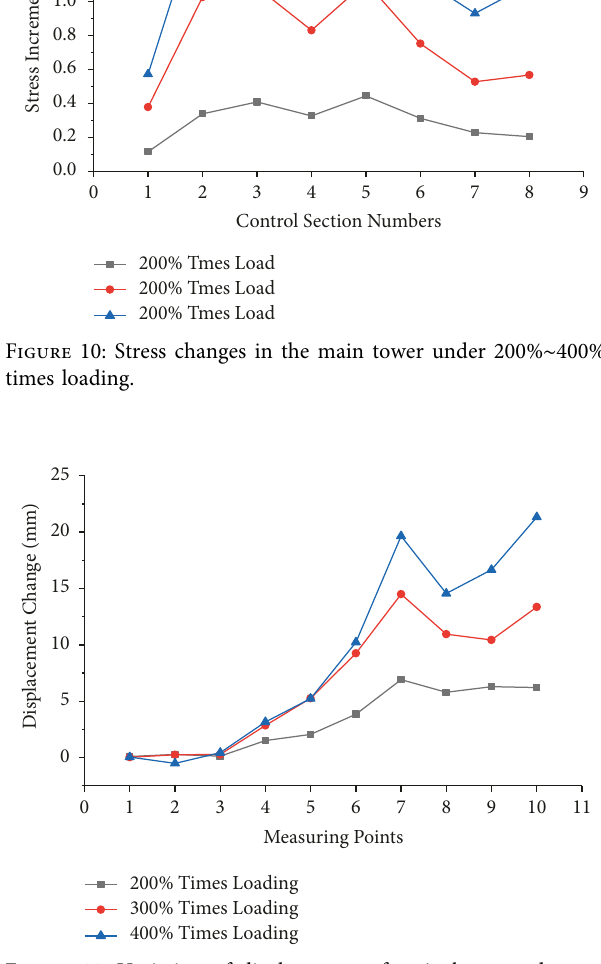
Figure 11: Variation of displacement of main beam and tower under 200% ∼ 400% times loading.